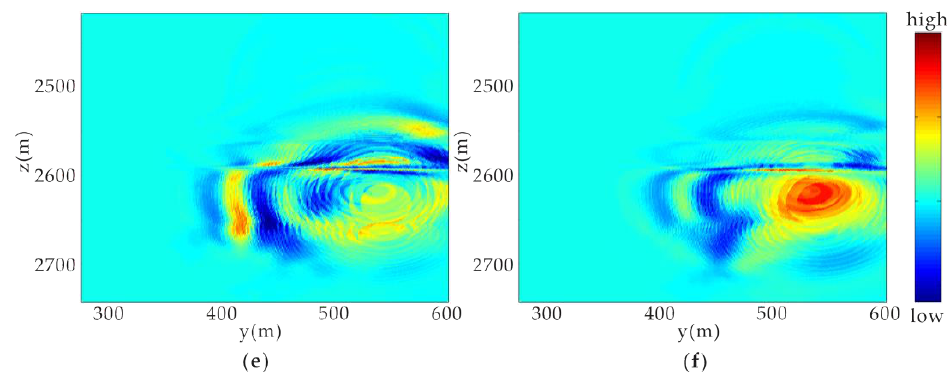
Figure 8. Waveform stacking function distribution for one of the identified microseismic events through applying the conventional and improved polarity correction methods. The horizontal slice of the waveform stacking function estimated in the xy -plane using ( a ) the conventional polarity correction method and ( b ) the improved polarity correction method. The vertical slice of waveform stacking function estimated in the xz -plane using ( c ) the conventional polarity correction method and ( d ) the improved polarity correction method. The vertical slice of waveform stacking function estimated in yz -plane using ( e ) the conventional polarity correction method and ( f ) the improved polarity correction method. The color scale denotes the waveform stacking function value (low values in blue and high values in red). The spot with the maximum value indicates the most likely position of the located event.